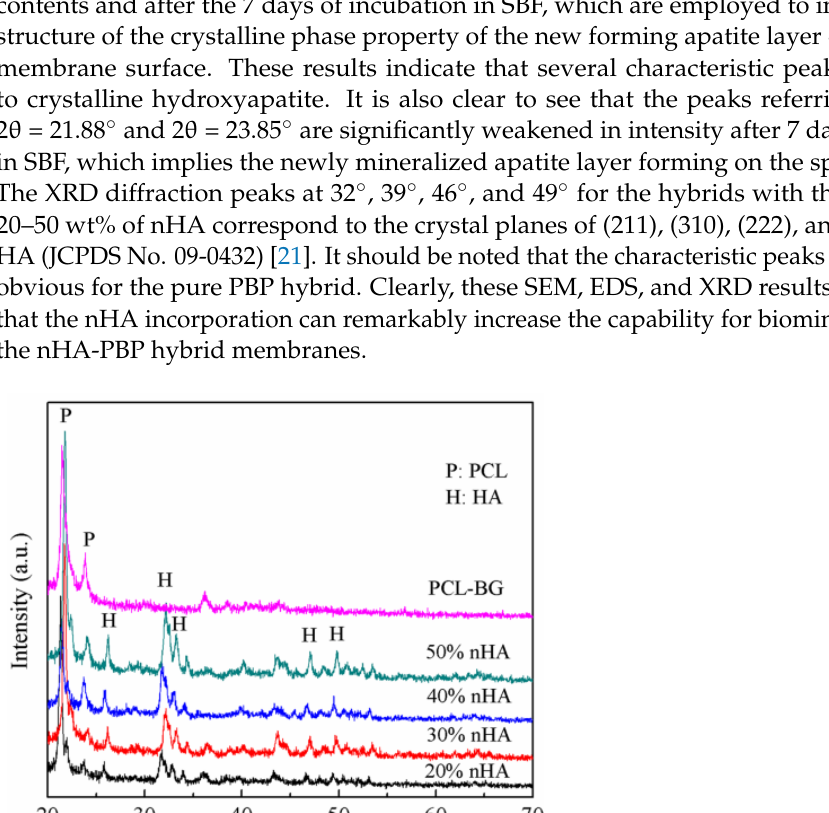
Figure 7. Elemental compositions of the nHA-PBP hybrid membranes with different nHA contents